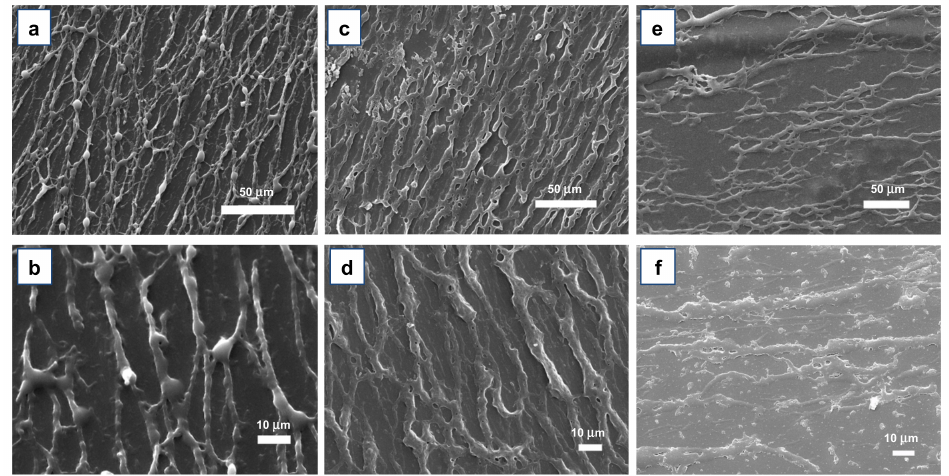
Figure 7. Low and high magnification SEM images of directional ASB-SANS-grown PLGA nanofibers after one hour ( a , b ), one week ( c , d ), and two weeks ( e , f ) of immersion in a PBS bath kept at 37 ◦